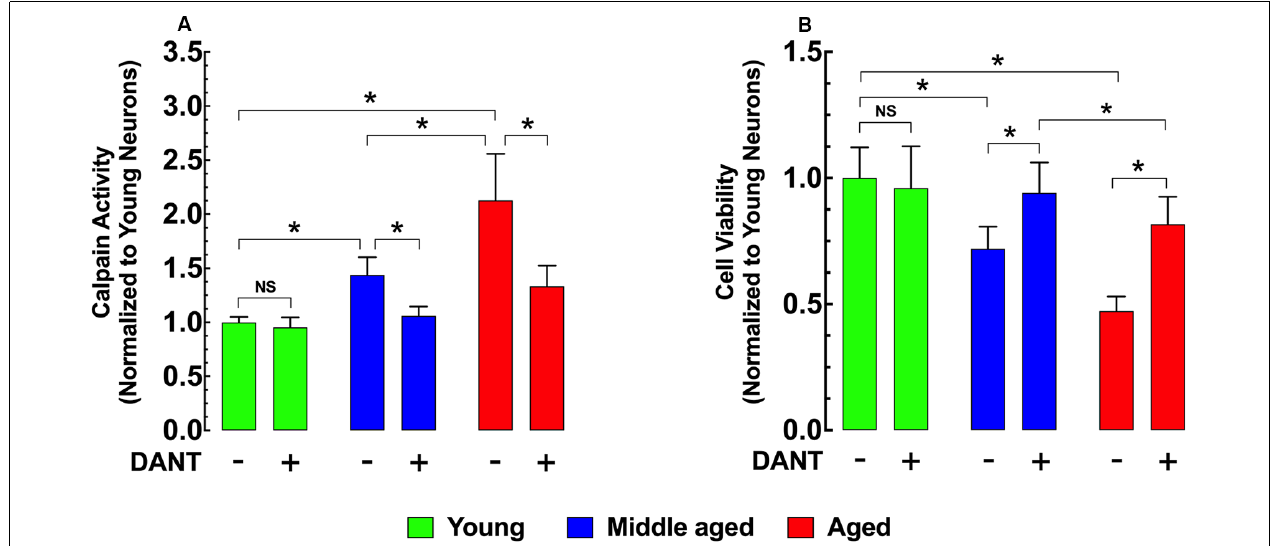
FIGURE 3 | Effects of dantrolene on calpain activity and cell viability in aged hippocampal neurons. Calpain activity was higher in middle-aged and aged hippocampal neurons than young neurons (A) , and these differences were accompanied by a decreased cell viability in middle-aged and aged hippocampal neurons compared to young neurons (B) . Dantrolene (20 µ M) reduced calpain activity, and increased cell viability in aged hippocampal neurons. On the horizontal axis are indicated the experimental conditions. For calpain: n mice = 3/age group; for cell viability: n mice = 4/per age group. Values are expressed as means ± S.D. for each condition. One-way ANOVA followed by Tukey’s post hoc comparisons, * p ≤ 0.05; NS, not